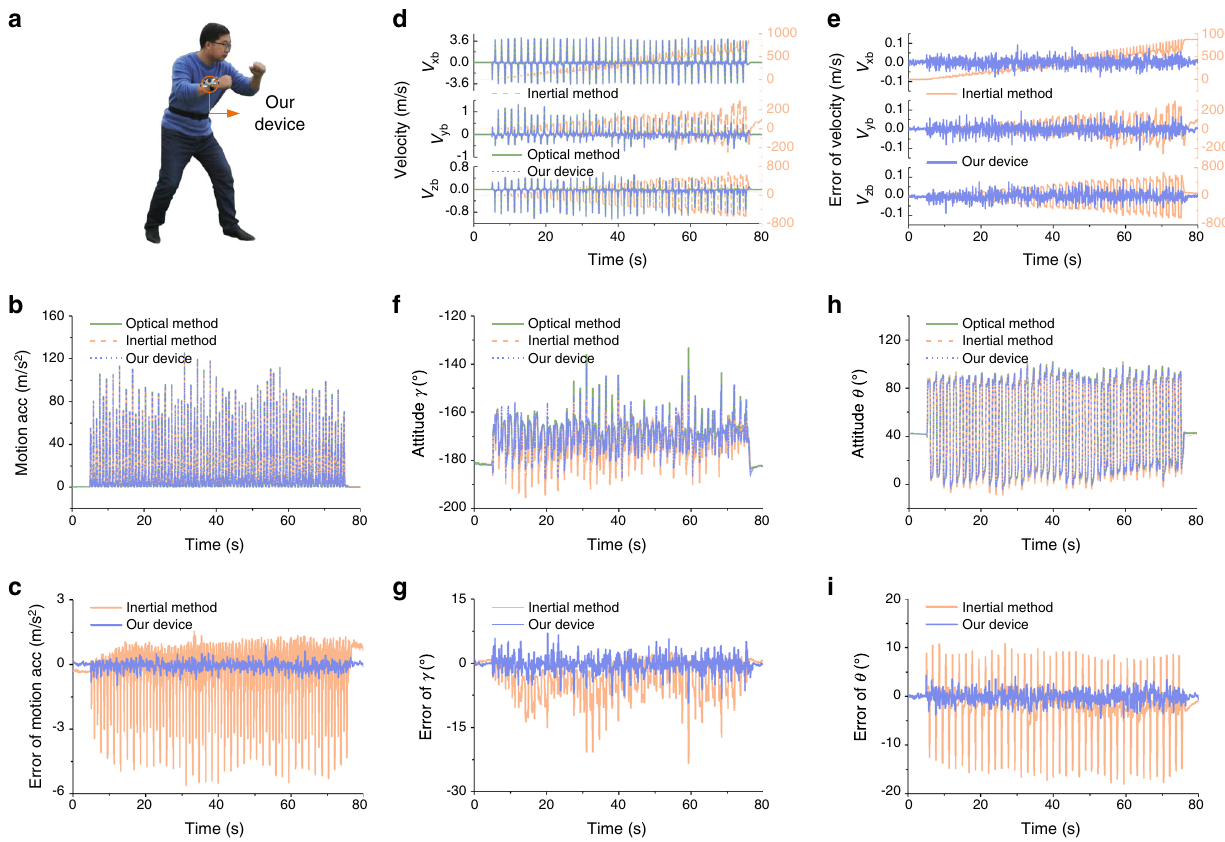
Fig. 4 Boxing motion capture results of forearm wearing a device. a The subject wears a device on his wrist and conducts boxing activity. b – c The magnitude of motion acceleration measured by our device and inertial method, respectively ( b ), and the corresponding errors ( c ). High dynamic motion with motion acceleration more than 120 m/s 2 is observed. d – e The tri-axis motion velocity measured by our device and inertial method, respectively ( d ), and the corresponding errors ( e ). f – i The attitude estimation results of roll angle γ ( f ) and pitch angle θ ( h ), respectively, and the corresponding attitude errors by our device and inertial method respectively ( g and i ). Motion capture results of optical VICON system are used as reference reaches 4.18° as shown in Fig. 4g, i, Fig. 5g, i and Supplementary